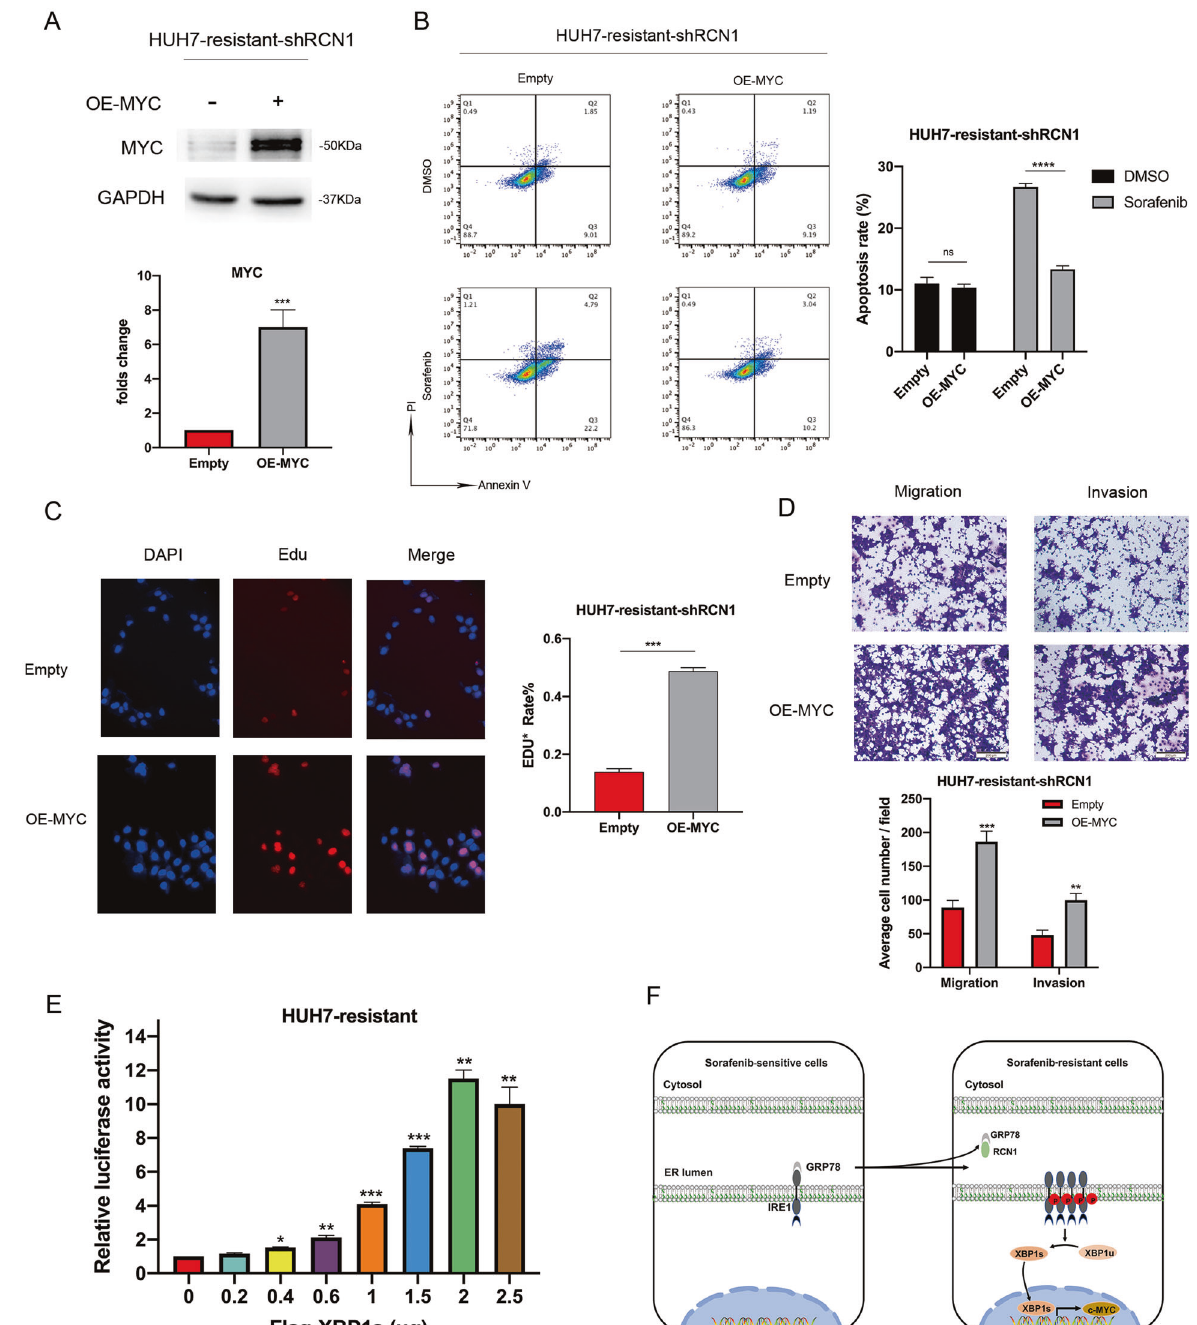
Fig. 7 RCN1 activates c-MYC signaling through the IRE1 α -XBP1s pathway in sorafenib-resistant cells. A c-MYC expression in sorafenib- resistant Huh7 cells with downregulated RCN1. B Flow cytometry analysis of Annexin V-PI staining in Huh7 RCN1-knockdown sorafenib- resistant cells with or without MYC overexpression, in the presence of 5 μ M sorafenib. C , D MYC overexpression rescues the inhibitory effect of RCN1 shRNA on the. proliferation, migration, and invasion of sorafenib-resistant cells. E Sorafenib-resistant Huh7 cells were transfected MYC luciferase reporter plasmids. with or without a fl ag-XBP1s plasmid. After 24 h, the cells were harvested for a luciferase activity assay. F Schematic model. The increasing expression of RCN1 results in an activation of the IRE1 α – XBP1s – c-MYC axis in sorafenib-resistant cells. Data are presented as the means ± SEM of three independent experiments; data for western blot have undergone quantitative analysis. ns: not signi fi cantly different. * P < 0.05; ** P < 0.01; *** P < 0.001; **** P < 0.0001, t